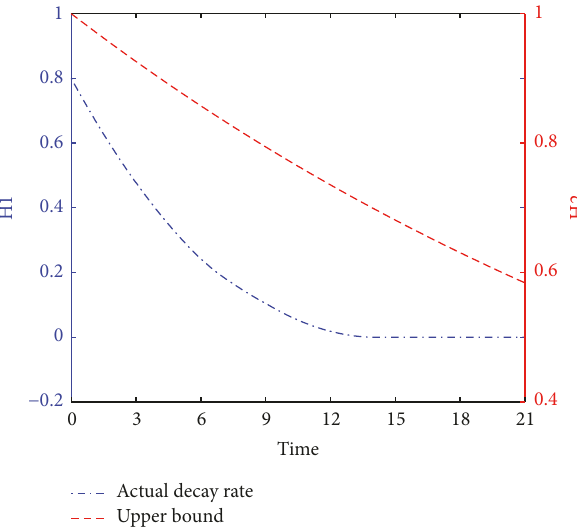
Figure 1: The simulation results of the actual decay rate ‖ x (𝑡)‖ 𝜐 ∞ and the guaranteed upper bound we calculated with the initial condition x (0) = [7, 8] 𝑇 and the MDT 𝜏 = 3